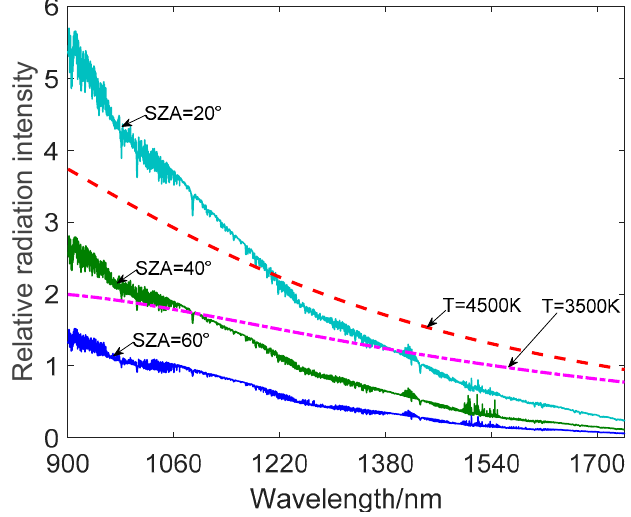
Figure 5. The spectral energy distribution of stars with different color temperatures and atmospheric background radiation at 20 km with different SZA.